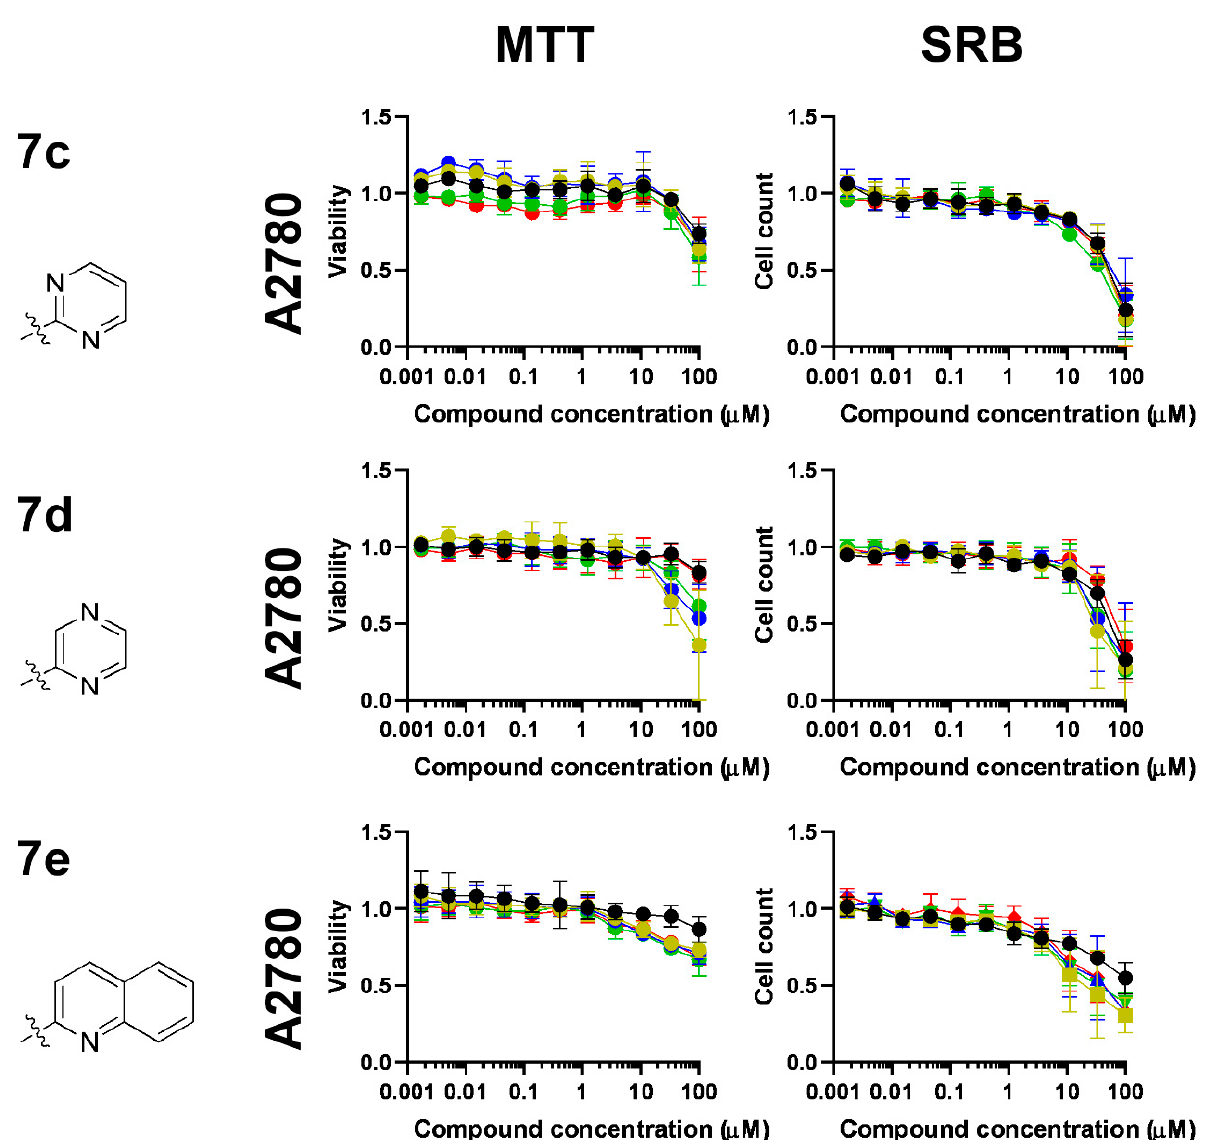
Figure 5. Assessment of free ligands 7c-e and their complexes ( Ru/Os/Ir/Rh-7c , Ru/Os/Ir/Rh-7d and Ru/Os/Ir/Rh-7e ) for cytotoxic and cytostatic activity. For the MTT and SRB assays, 3 × 10 3 A2780 cells and 1.5 × 10 3 A2780 cells were plated in 96-well plates, respectively. Cells were treated with the compounds in the concentrations indicated for either 4 h for the MTT assay or for 48 h for the SRB assay. Data are represented as average ± SD from three biological replicates; individual assays were performed in duplicate. Values were normalized for vehicle-treated cells; absorbance for vehicle-treated cells equals 1. Statistical significance was assessed using a one-way ANOVA test comparing all values to the lowest concentration of a compound. Before the test, normality was assessed using the Shapiro–Wilk test, and the post hoc test was chosen accordingly. For better visibility, the p values and distributions are presented in an Excel sheet available at https://figshare. indicated in Table 6. Color code: black—free ligand ( 7c or 7d or 7e ), khaki—ruthenium complex ( Ru-7c or Ru-7d or Ru-7e ), blue—osmium complex ( Os-7c or Os-7d or Os-7e ), green—iridium complex ( Ir-7c or Ir-7d or Ir-7e ), red—rhodium complex ( Rh-7c or Rh-7d or Rh-7e ).